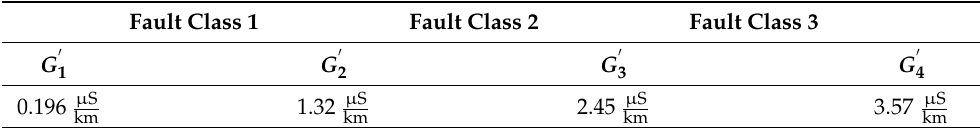
Table 6. Fault classes based on conductance